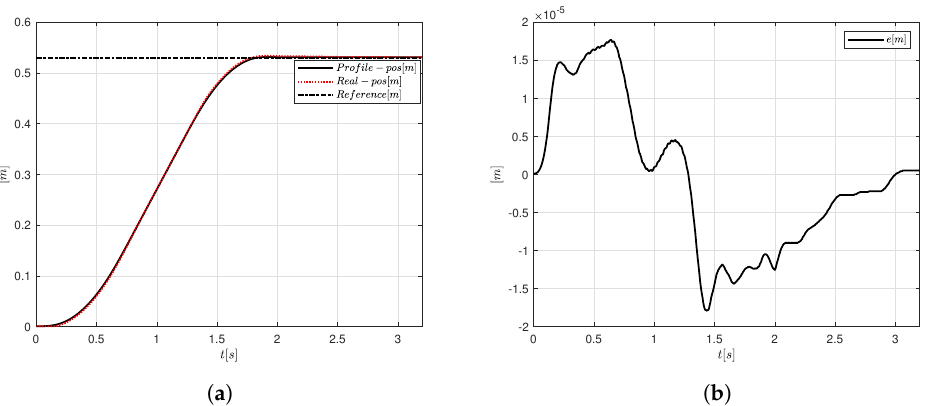
Figure 15. Motion controller based on PID-like FLC and S-curve velocity profile implementation adding a cylindrical load of 1.9 kg, ( a ) position and ( b ) error.